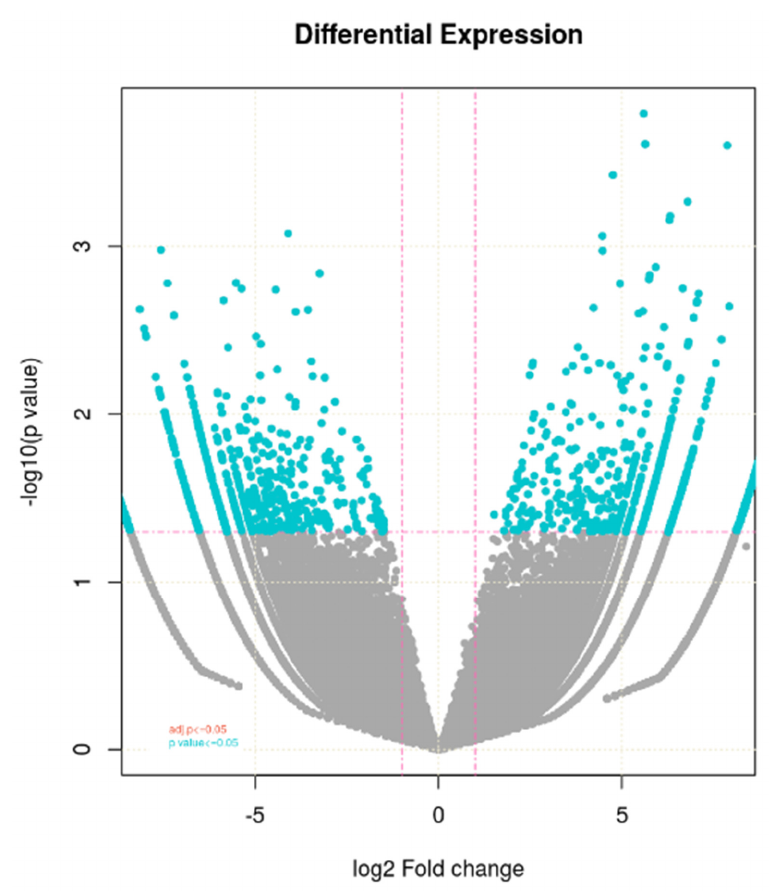
Figure 2. Volcano plot showing differential expressed genes identified between the control and heat treated WH-1184.